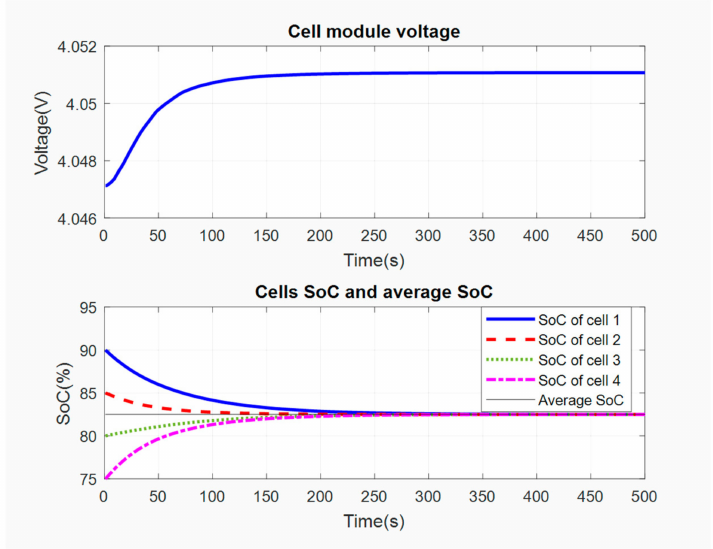
Figure 5. The changing of the cell module voltage and the states of charge (SoC) of four cells in the cell